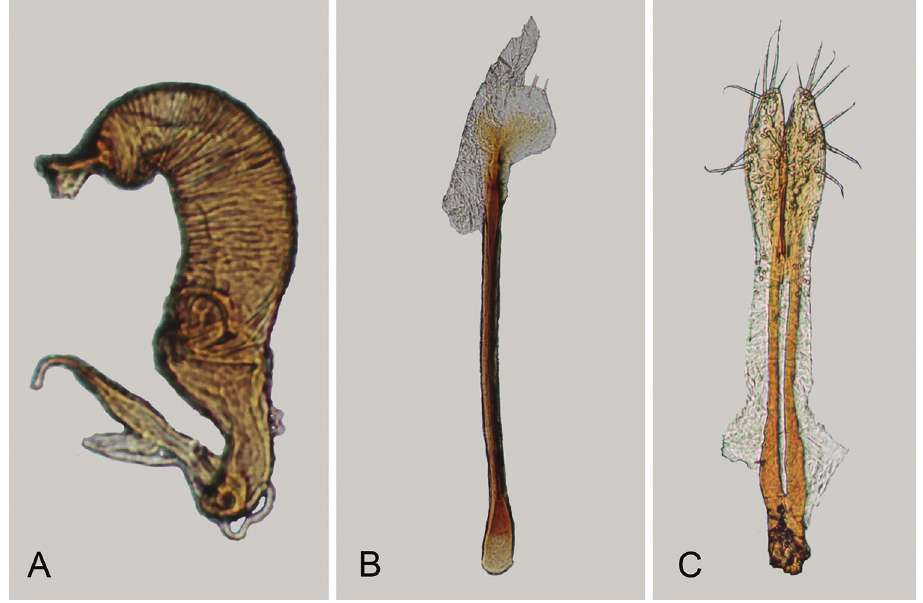
Figure 4. Andersonoplatus baru . A Spermatheca B Tignum C Vaginal palpi. pump not differentiated from each other. Apex of pump with spoon-like